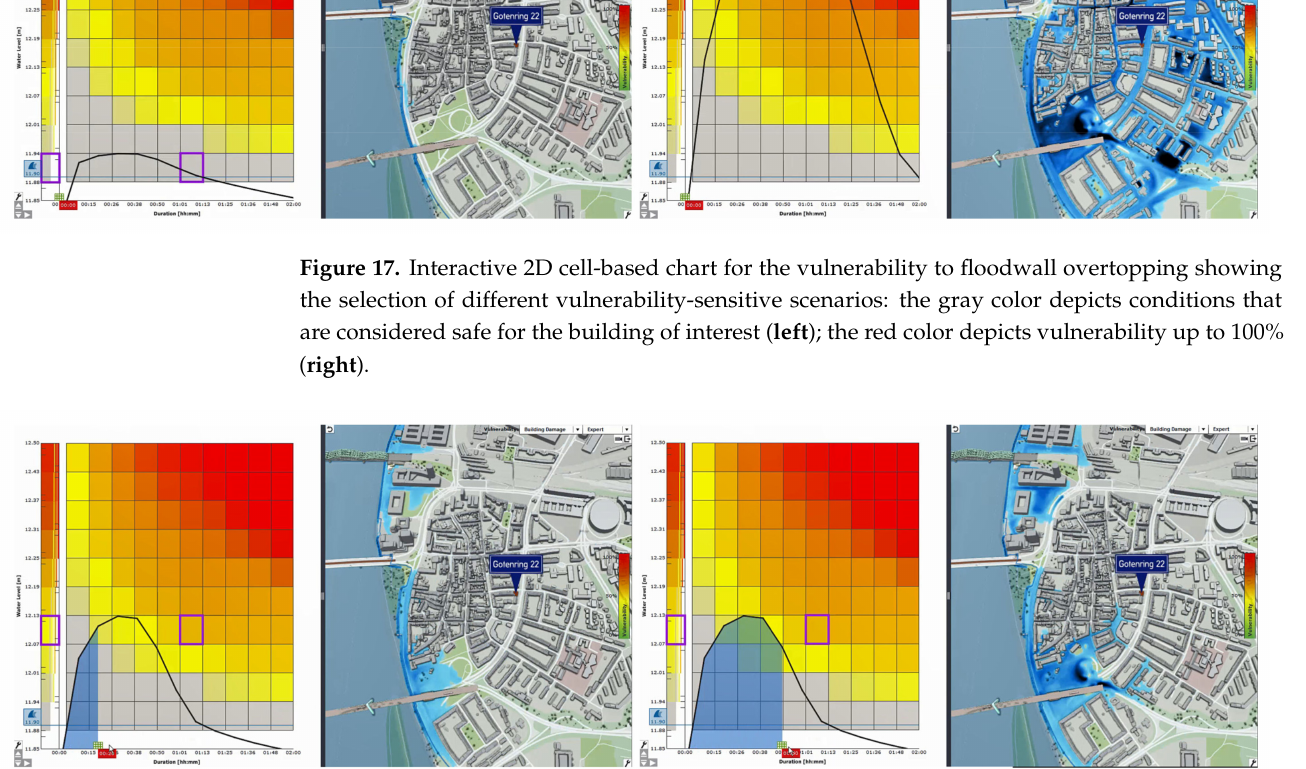
Figure 18. Interactive 2D cell-based chart for the vulnerability to floodwall overtopping showing gauge with water levels on the far left of each interface view, along the hydrograph (black line) and time navigation bar